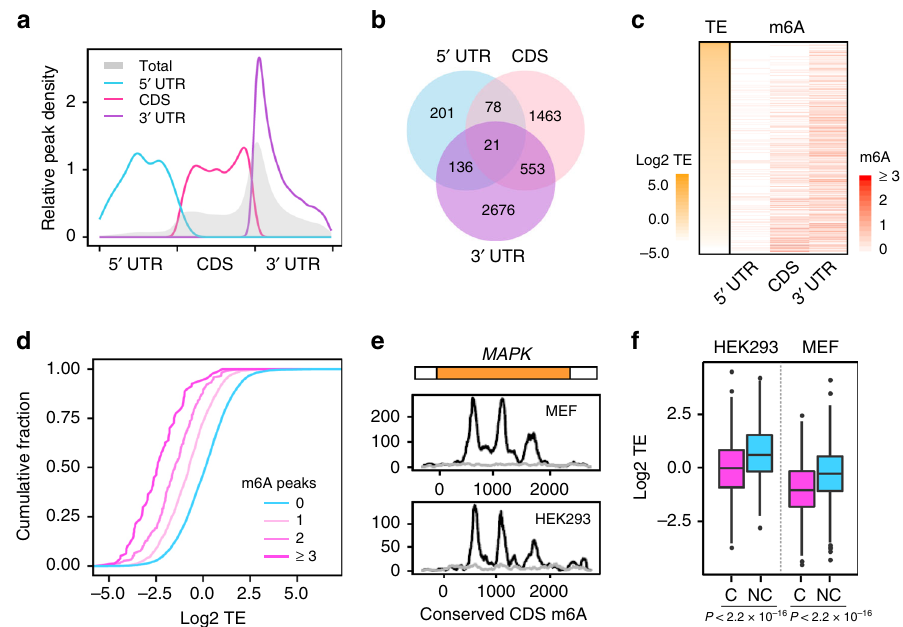
Fig. 1 CDS m 6 A is enriched in transcripts with inactive translation. a Distribution of m 6 A sites along transcripts with different regional methylation. Transcripts are grouped into 5 ′ UTR, CDS, and 3 ′ UTR methylation based on the identi fi ed m 6 A sites. Only METTL3 or WTAP sensitive m 6 A sites are considered. The distribution of total m 6 A sites was shown in gray. UTR: untranslated region, CDS: protein coding region. b A Venn diagram shows the overlapping of transcripts containing m 6 A sites in different regions. c Translation ef fi ciency (TE, left column) and m 6 A density across the transcriptome are presented as parallel heat-maps. Note the inverse correlation between CDS m 6 A methylation and TE. d Translation ef fi ciency (TE) is plotted as accumulative fractions for mRNAs with different amount of m 6 A peaks in CDS. e A representative example ( MAPK ) of evolutionary conserved m 6 A sites between MEF and HEK293 cells. The coverage of m 6 A is shown as black lines and the input as gray. f A box plot shows the translation ef fi ciency (TE) of mRNAs containing conserved (C) and non-conserved (NC) m 6 A sites in MEF and HEK293 cells (Wilcox test, all P values< 2.2 × 10 − 16 ). The median of TE in each group is indicated by a center line, the box shows the upper and lower quantiles, whiskers shows the 1.5× interquartile range, and the outliers are indicated by points. Source data are provided as a Source Data fi